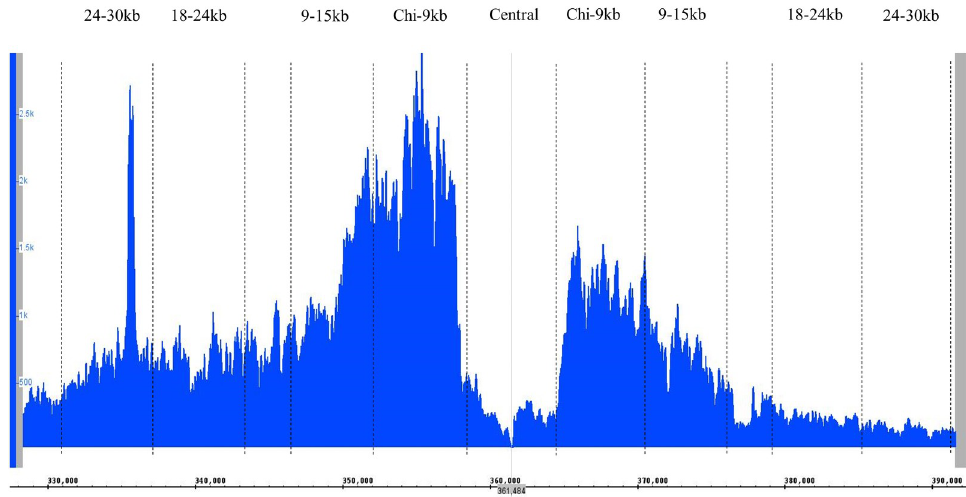
Fig 4. ChIP-Seq analysis on RecA loading in the 60kb DSB repairing region. ChIP-Seq analysis of DSB-dependent RecA loading in the lacZ region of strain DL5216 ( lacZ ::246bp palindrome, mhpA ::3xChi, lacZY ::3xChi) undergoing DSB repair. The 246 bp palindrome is located at 361268–361514 kb (marked by vertical grey line) on the map. The number of hits is depicted in blue. The NotI cutting sites are shown by black dashed lines and the resulting fragments are denoted at the top by their distances from the DSB